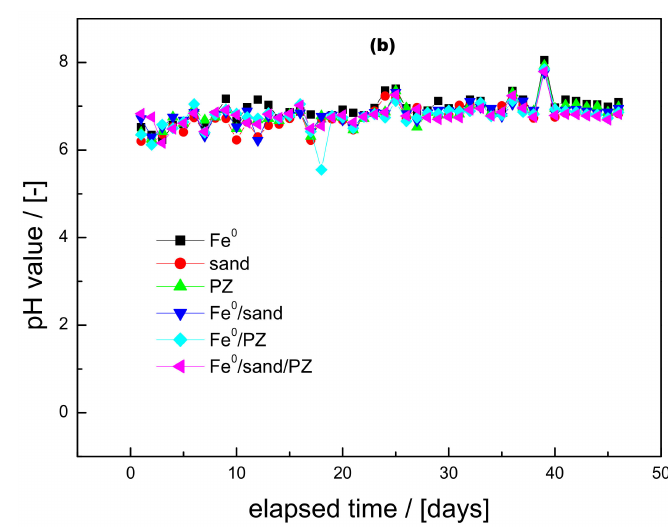
Figure 2. Time-dependent changes in effluent ( a ) iron concentration and ( b ) pH value for the 6 investigated systems. Experimental conditions: 6 g Fe 0 ; [MB] = 2.0 mg · L − 1 . Filling materials: metallic iron (Fe 0 ), sand and pozzolan (PZ). Column length 11.5 cm; column diameter 3.0 cm. The lines are not fitting functions, they simply connect points to facilitate visualization.